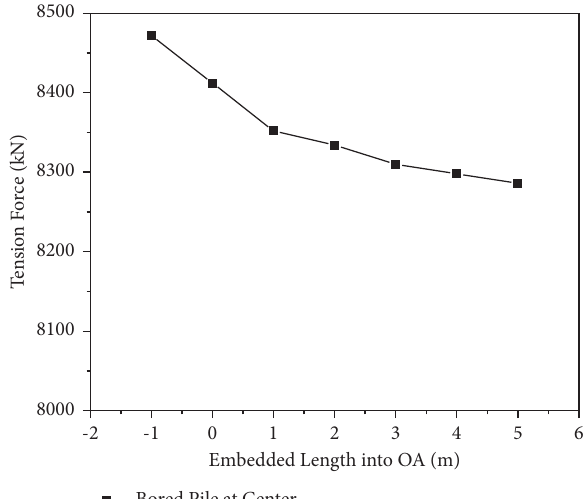
Figure 12: The effect of retaining wall embedded length into OA on tension force of bore pile at